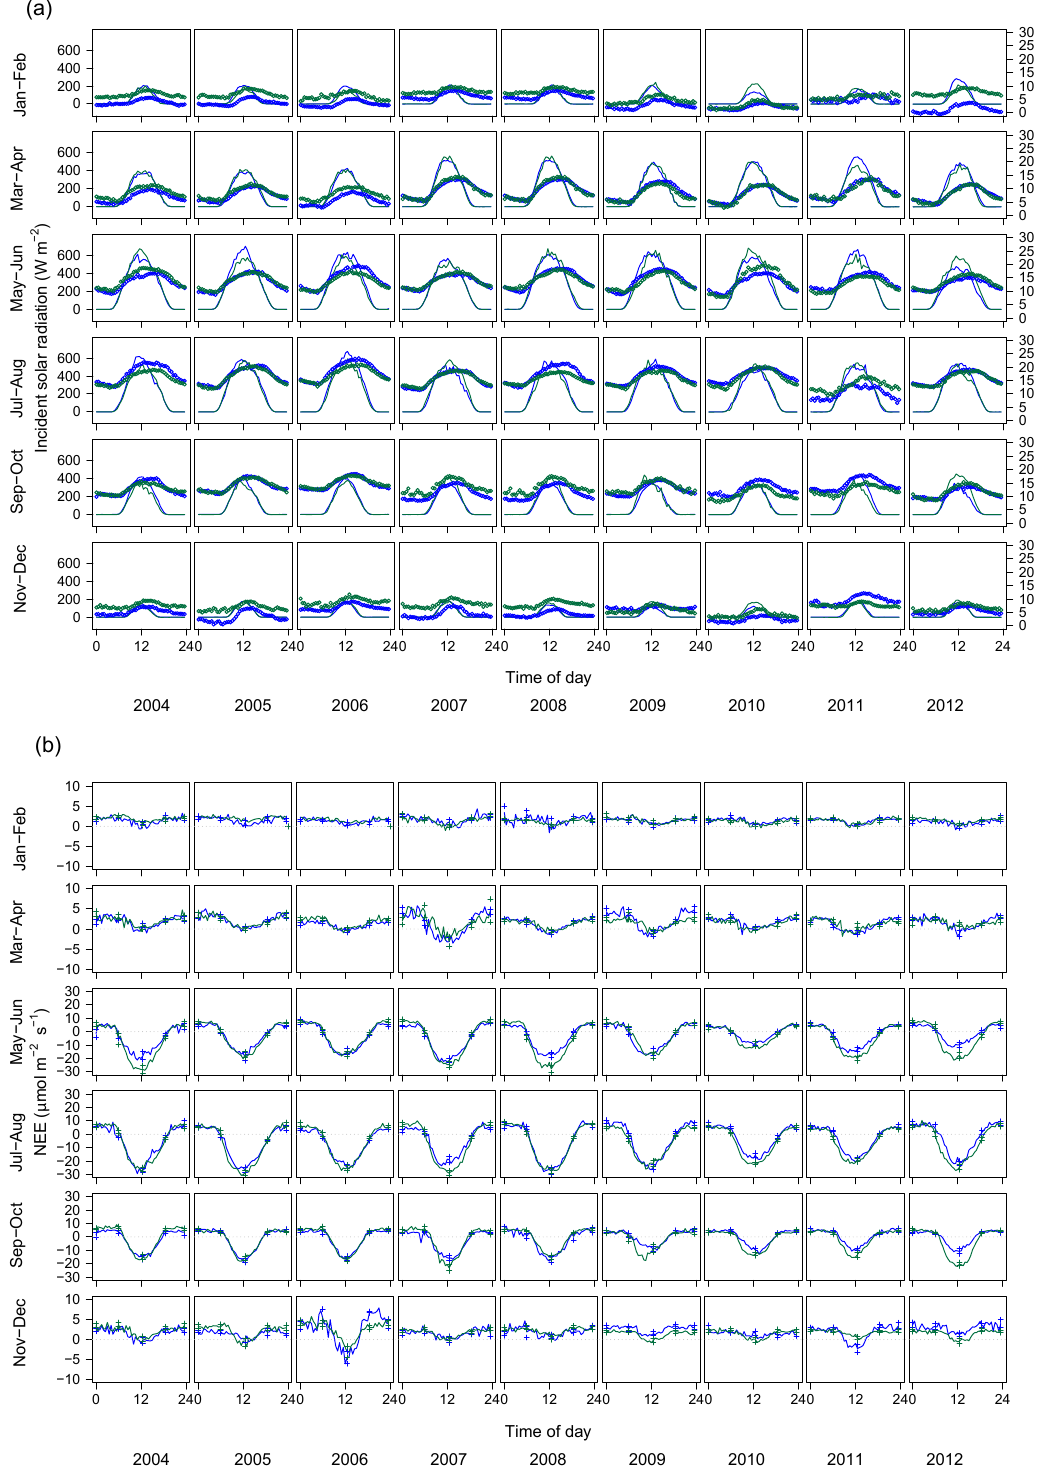
Figure 3. Panel (a) : average bimonthly diurnal curve of incident solar radiation, S g , for east sector (blue solid line) and west sector (green solid line) and air temperature for east sector (blue open circles) and west sector (green open circles) for 2004, 2007 and 2012 at the Straits Inclosure, Alice Holt Forest. Panel (b) : mean bimonthly diurnal curve of net ecosystem exchange for east sector (blue solid line) and west sector (green solid line) for 2004, 2007 and 2012; + symbols represent ± 1SE at the Straits Inclosure, Alice Holt